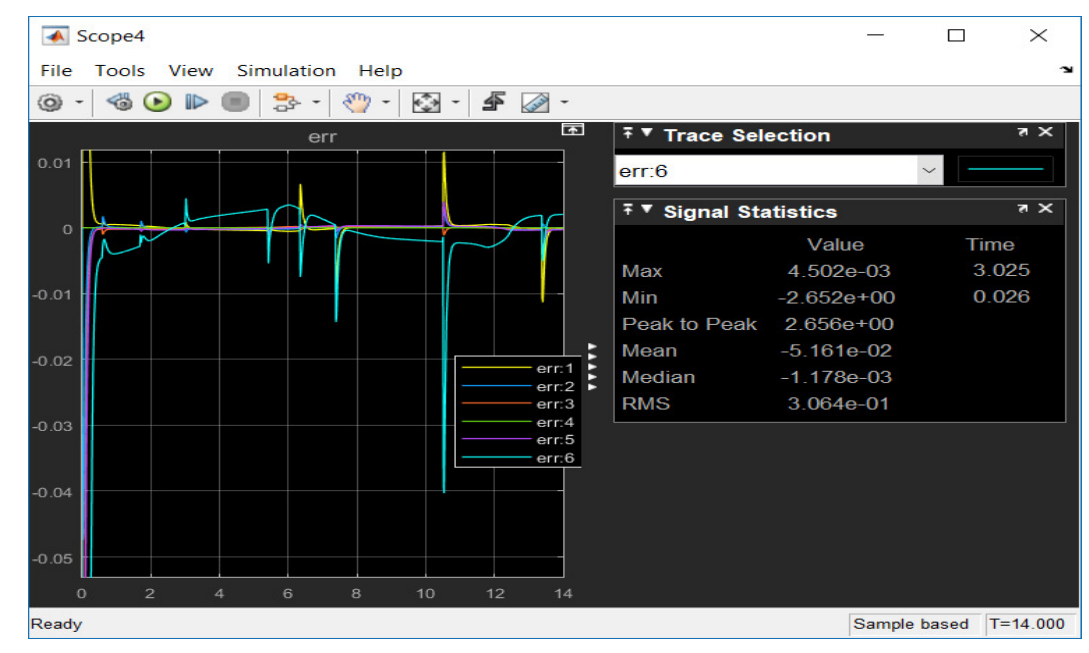
Fig. 14. Error Statistics/ PD-CTC.